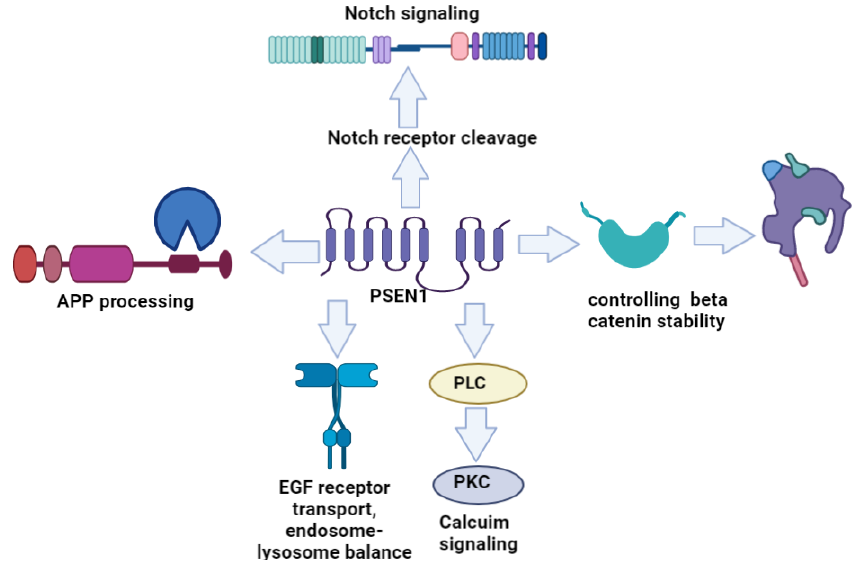
Figure 1. Pathways, in which PSEN1 may be